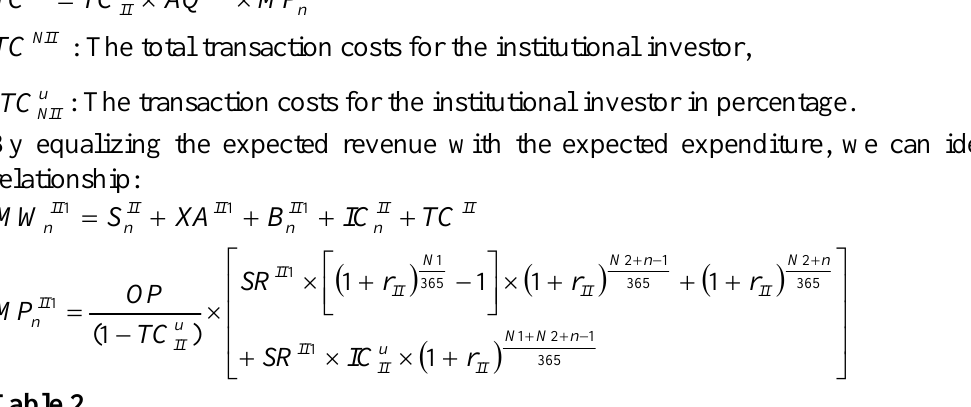
The determinants of the minimum price required by an institutional investor The determinants Expected